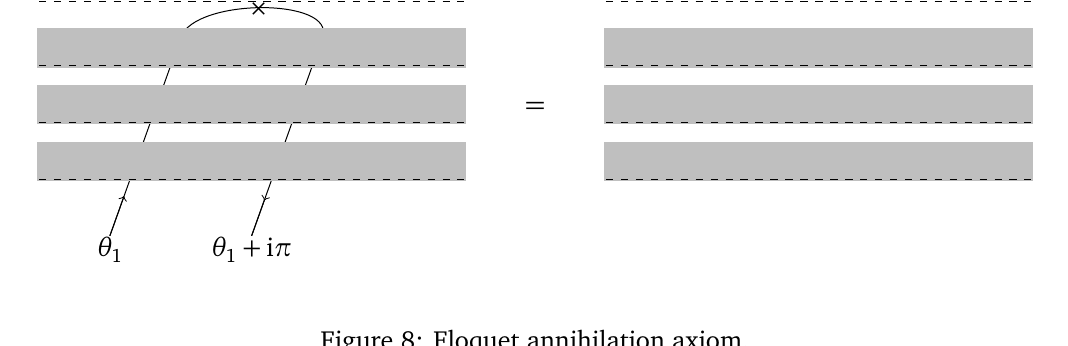
Figure 8: Floquet annihilation axiom.